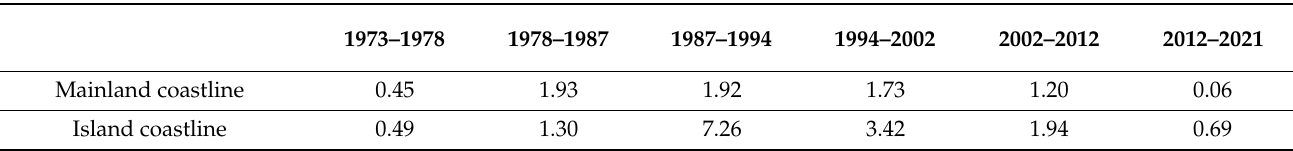
Table 3. Average annual growth of mainland shoreline and island coastline in Pearl River Estuary (unit: